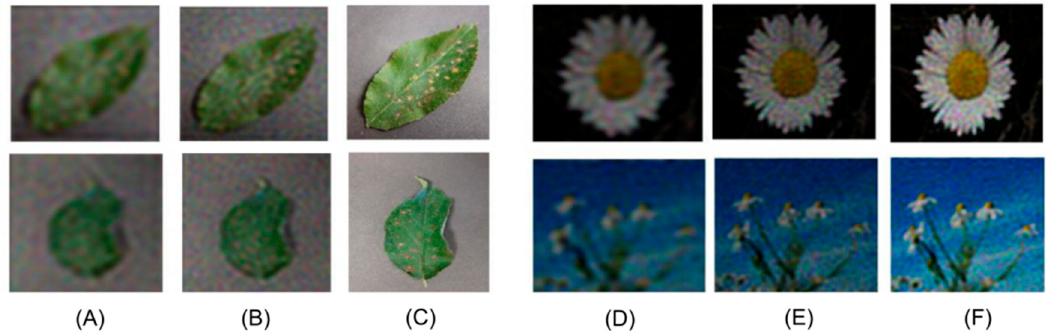
Figure 10. ( A ) Lower resolution apple pathology image; ( B ) FPM-reconstructed apple pathology image; ( C ) original apple pathology image; ( D ) lower resolution flowers image; ( E ) FPM-reconstructed flowers image; ( F ) original flowers image . Table 1. PSNR, SSIM, and classification accuracy for CIFAR and CalTech101 .